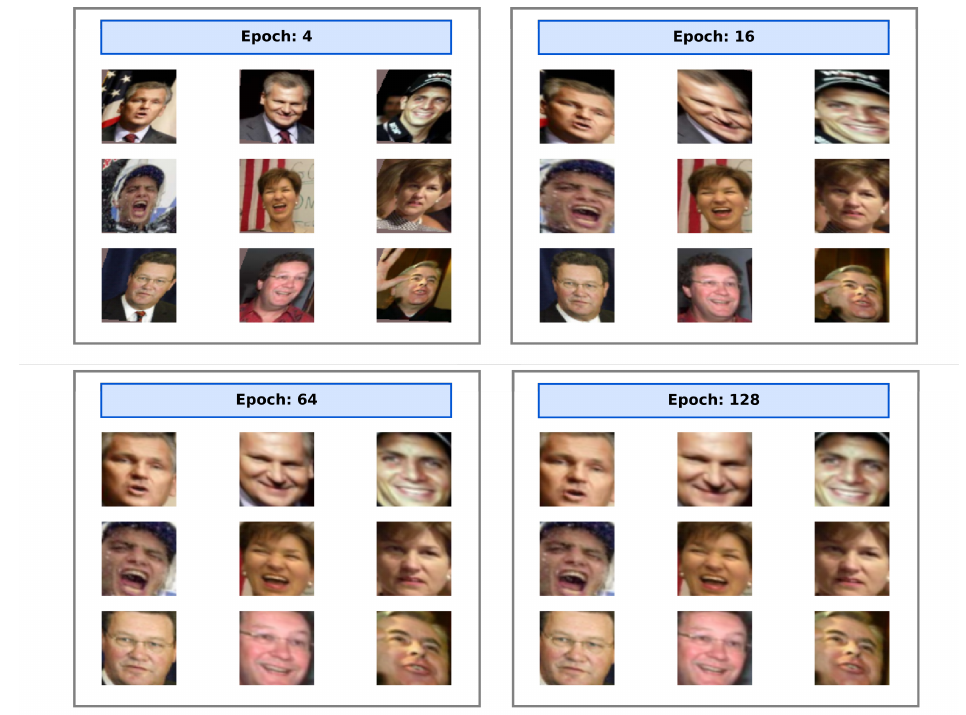
Figure 13. This figure shows the evolution of the STN output during the training of ‘distilled net+stn’. In less than 10 epochs, the STN correctly localizes the faces, while in 30 epochs the STN correctly learns to localize and align images for the recognition network.